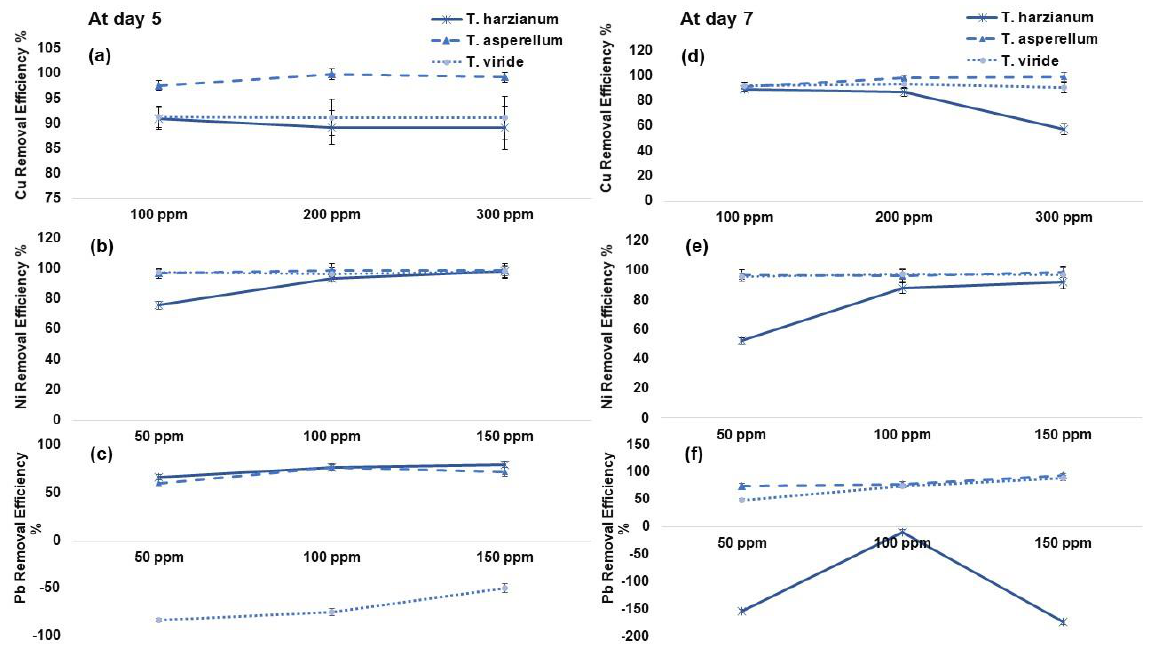
Figure 2. ( a – c ) Removal efficiency % of copper (Cu), nickel (Ni) and lead (Pb) by Trichoderma harzianum (F1), Trichoderma asperellum (F2) and Trichoderma viride (F3) at day 5. ( d – f ) Removal efficiency % of copper (Cu), nickel (Ni) and lead (Pb) by Trichoderma harzianum (F1), Trichoderma asperellum (F2) and Trichoderma viride (F3) at day 7, respectively. Values are the average of three replicates. It was reported that the HM adsorbed per DW of fungal isolate F2 was relatively higher at day 7 as compared to F1 and F3 (Figure 3). Under Cu toxicity, there was an increase (13 and 23%) in Cu uptake per DW of fungi reported with F2 application as com- pared to F1 and F3, respectively. Similarly, Ni uptake of T. asperellum (F2) was 9-fold higher as compared to F3 @ 150 ppm. However, the Pb uptake by F2 showed a negative trend at day 5 with respect to F1 and F2, while F2 demonstrated the maximum Pb uptake per DW (10- and 5-fold) of fungi at day 7 as compared to F1 and F3 with Pb @ 150 ppm, respectively.